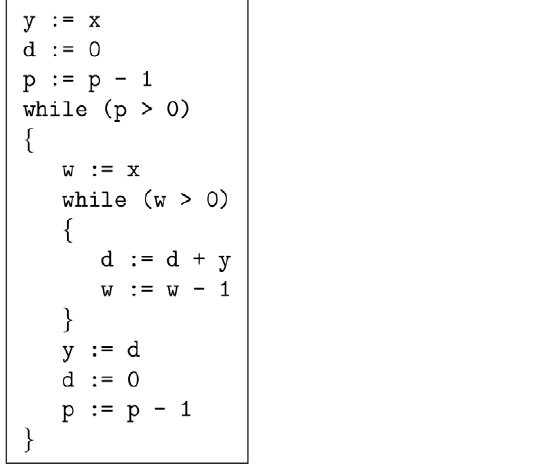
Figure 1. Pseudo-code to implement raise-to-a-power opera- tion.